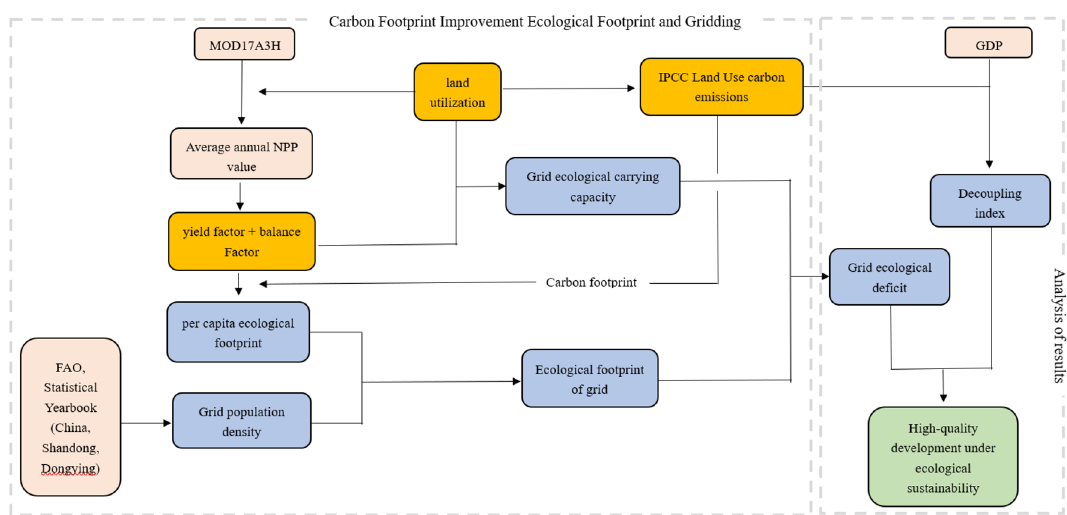
Figure 2. Ecological sustainability and high-quality development assessment process under grid ecological footprint and low-carbon